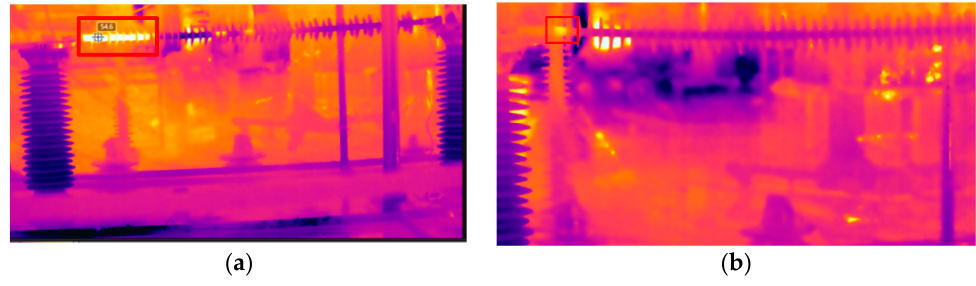
Figure 3. ( a ) Test object #1’s infrared image; ( b ) test object #2’s infrared image.